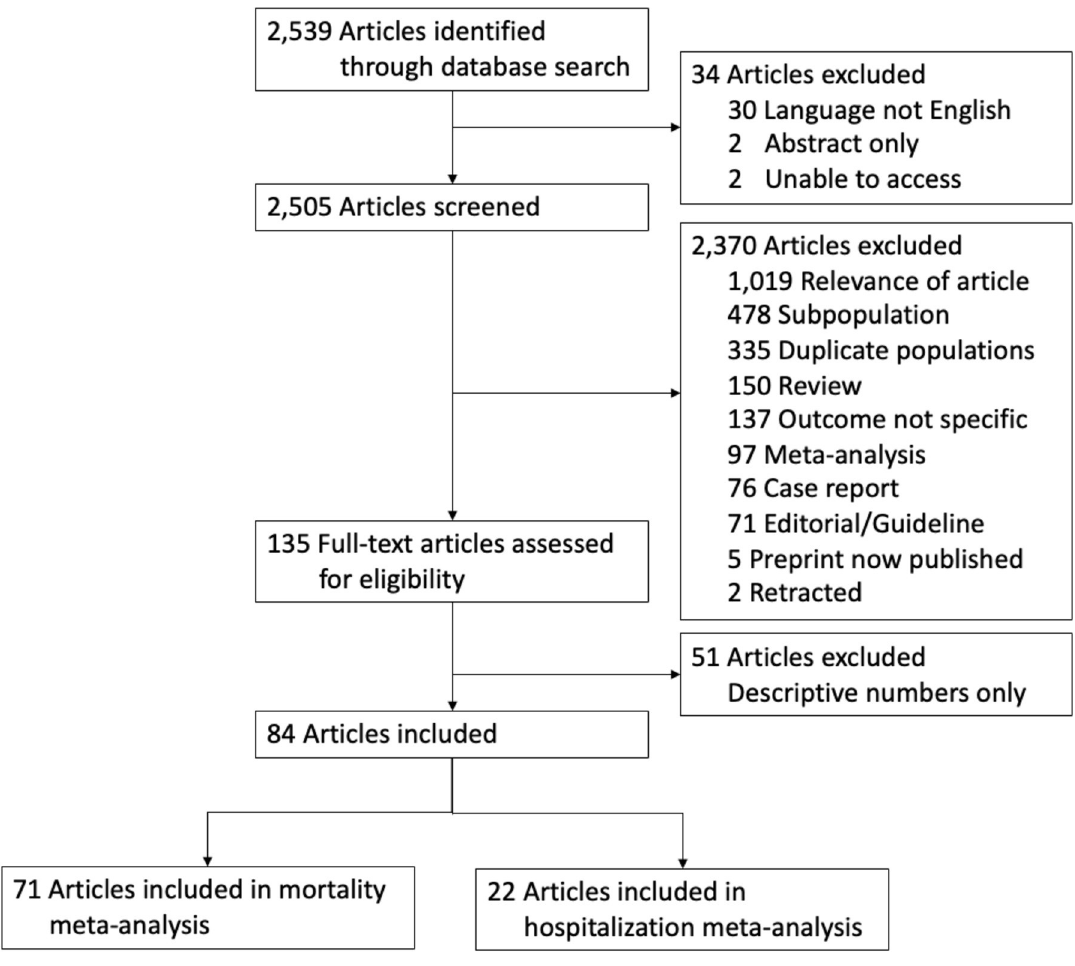
Fig 1. Flow diagram for article inclusion and